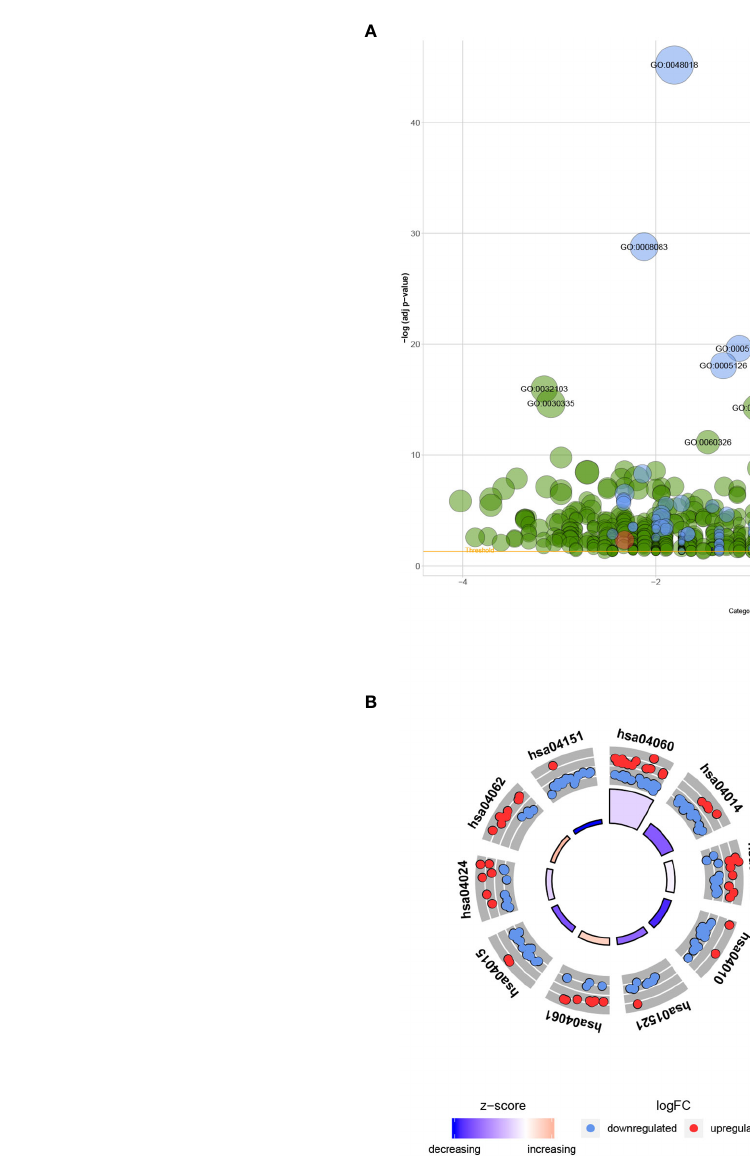
FIGURE 4 | Functional annotation of differentially expressed IRGs: (A) Enriched GO terms bubble plot. Green circles correspond to the biological process, red indicates the cellular component, and blue shows the molecular function category. (B) KEGG pathways circle diagram. Red circles represent upregulation, and blue ones represent